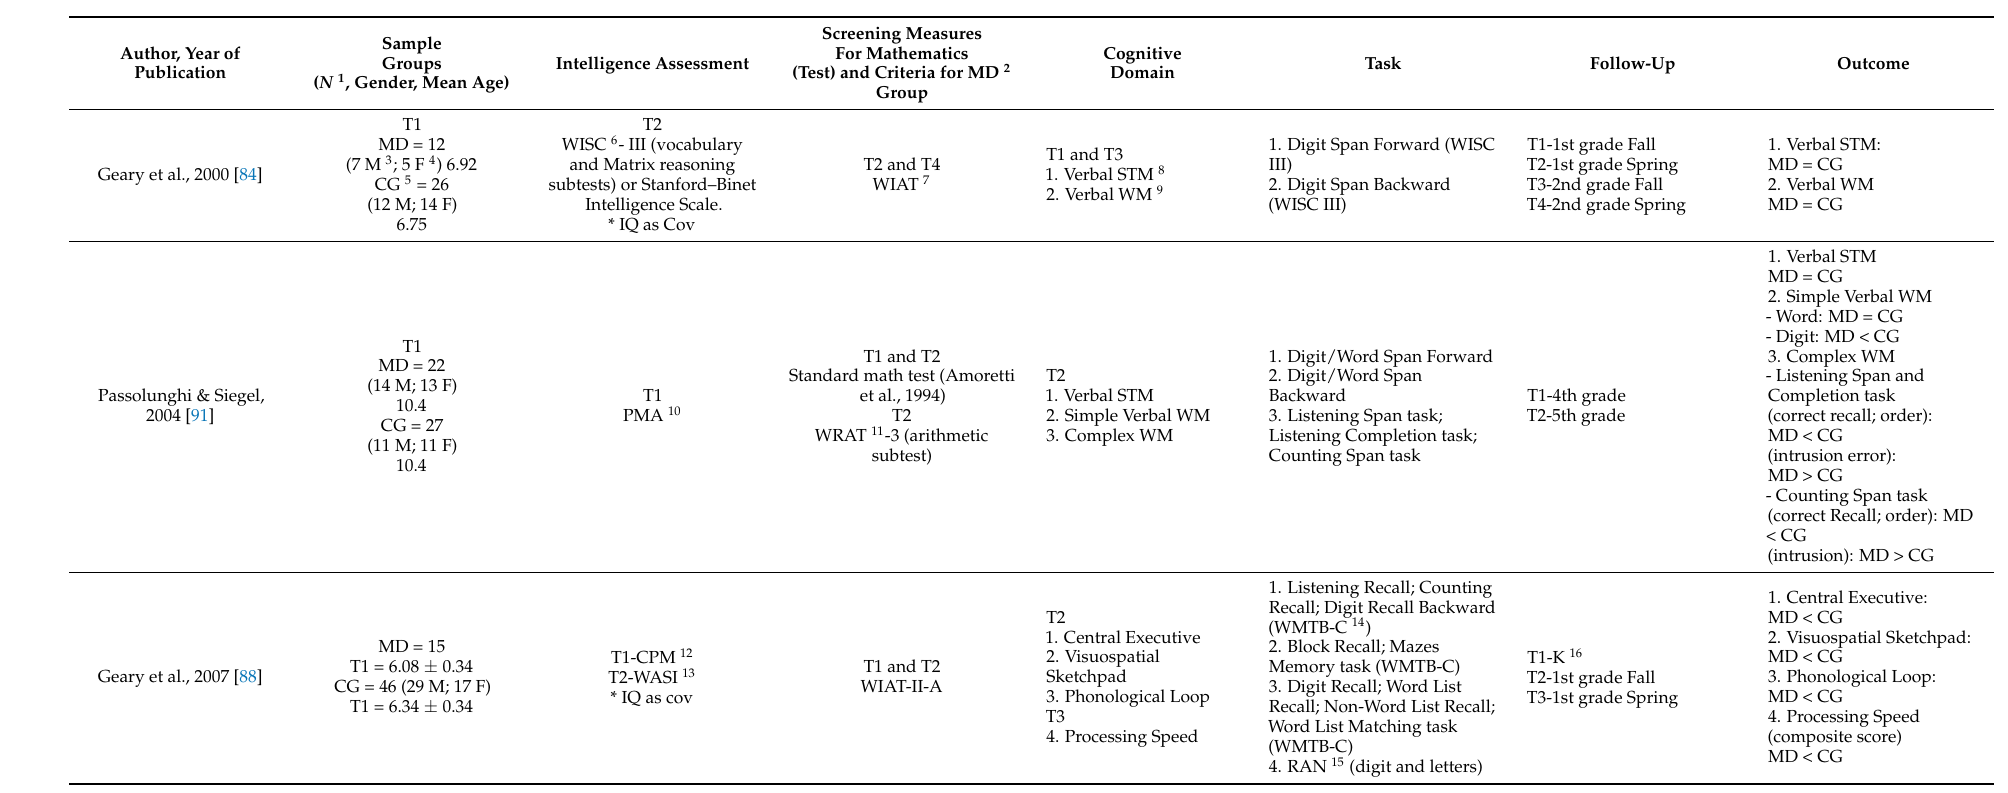
Table A2. Characteristics of the longitudinal